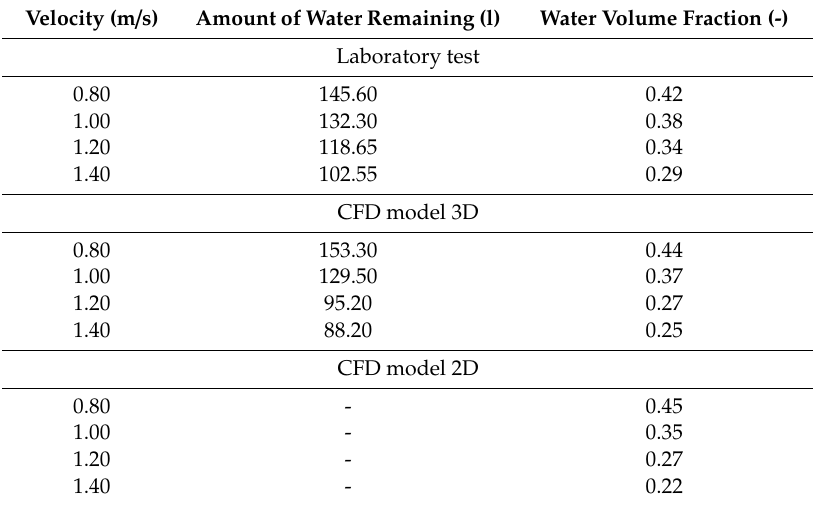
Table 1. Values of the residual water volume in the siphon obtained from the measurements and modelling